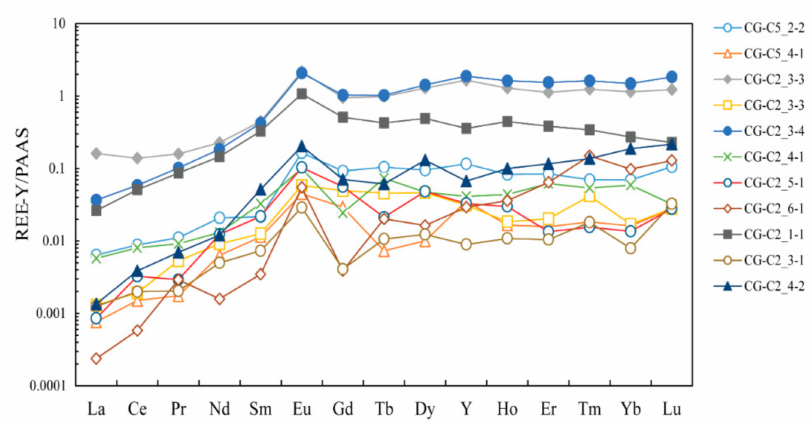
Figure 12. PAAS-normalized REY patterns of selected average magnetite from the Nabeba oxide